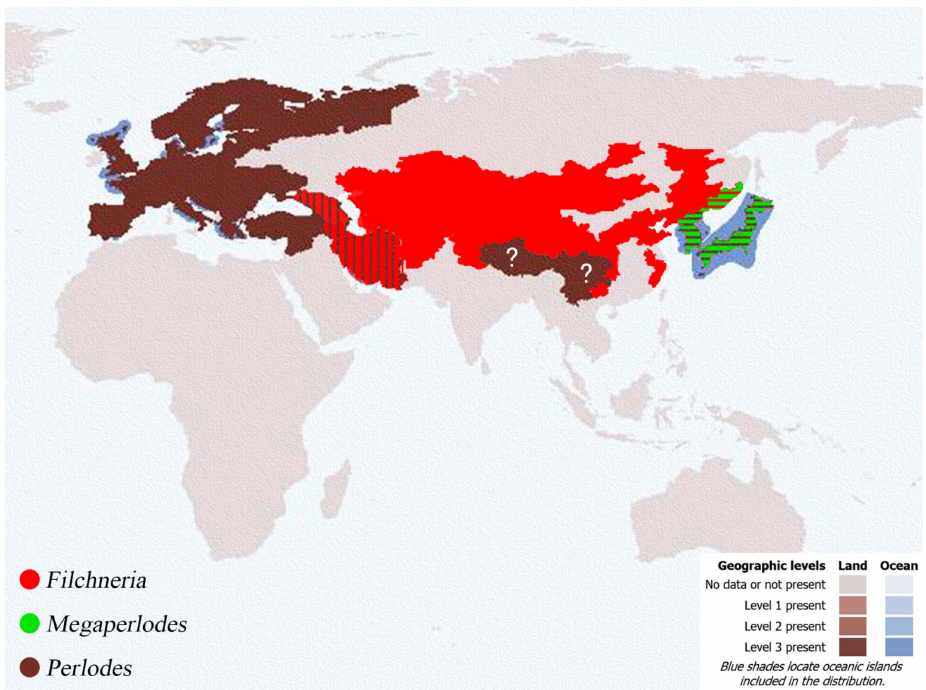
Figure 18. Distribution of Filchneria, Megaperlodes and Perlodes . Map modified according to